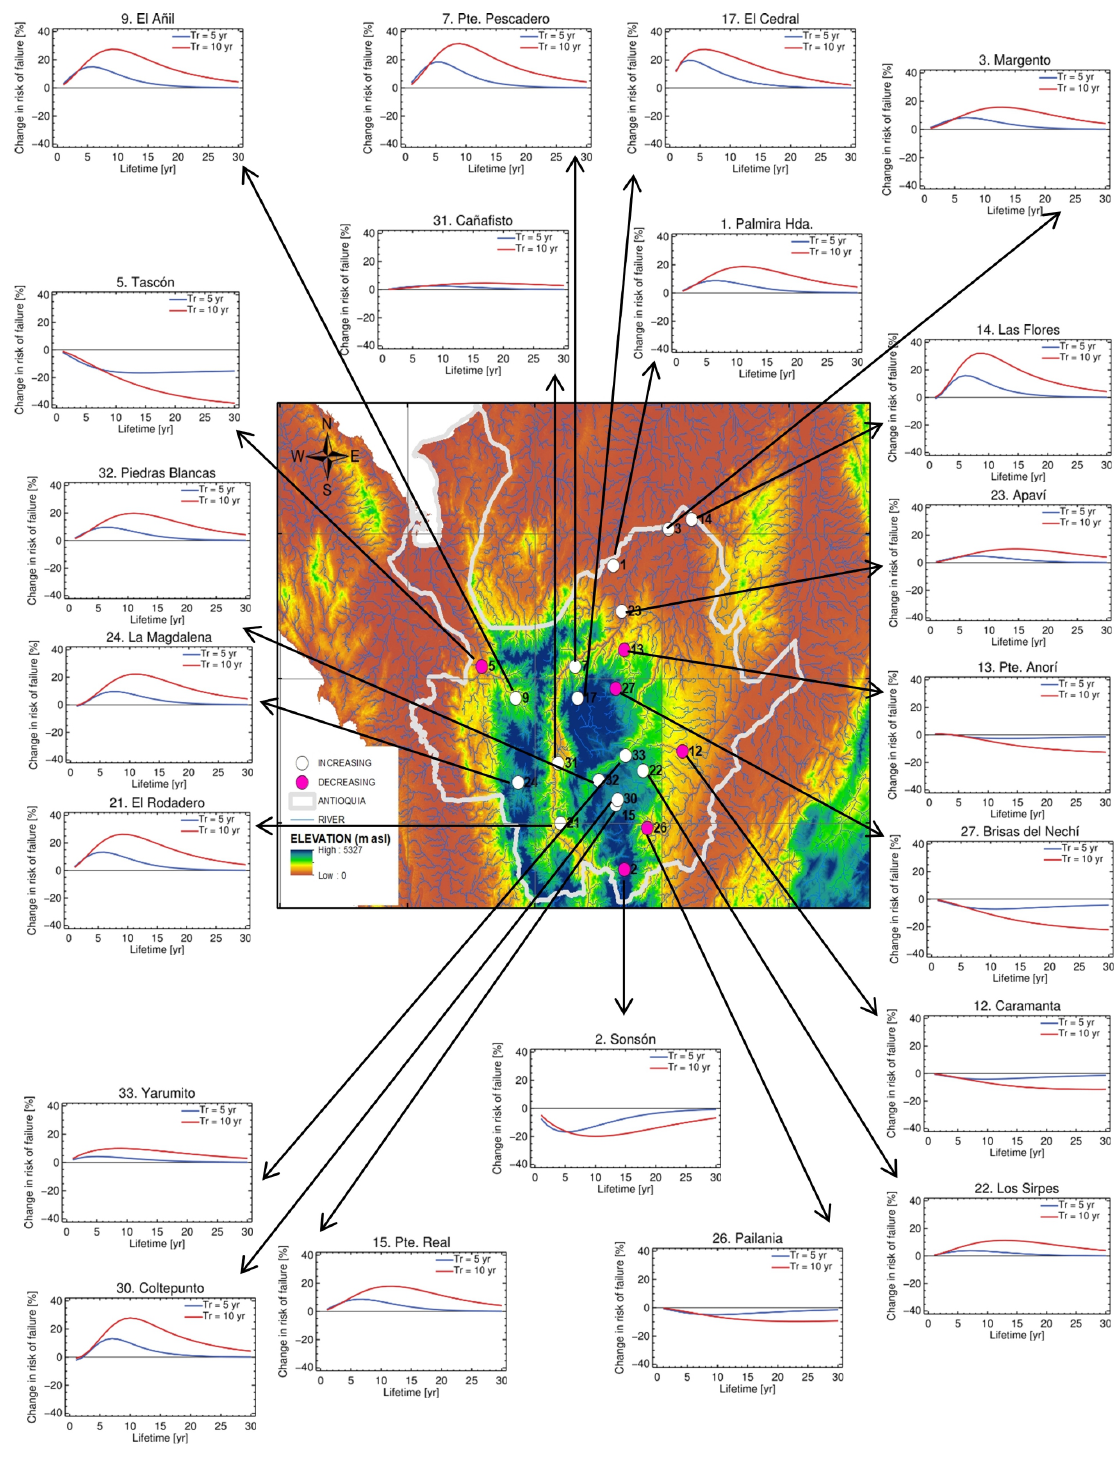
Figure 3. Geographical distribution of trends (+) and (-) and change in the risk of failure when including the effect of non-stationary for 5-yr and 10-yr return period design for all the non-stationary series of the data